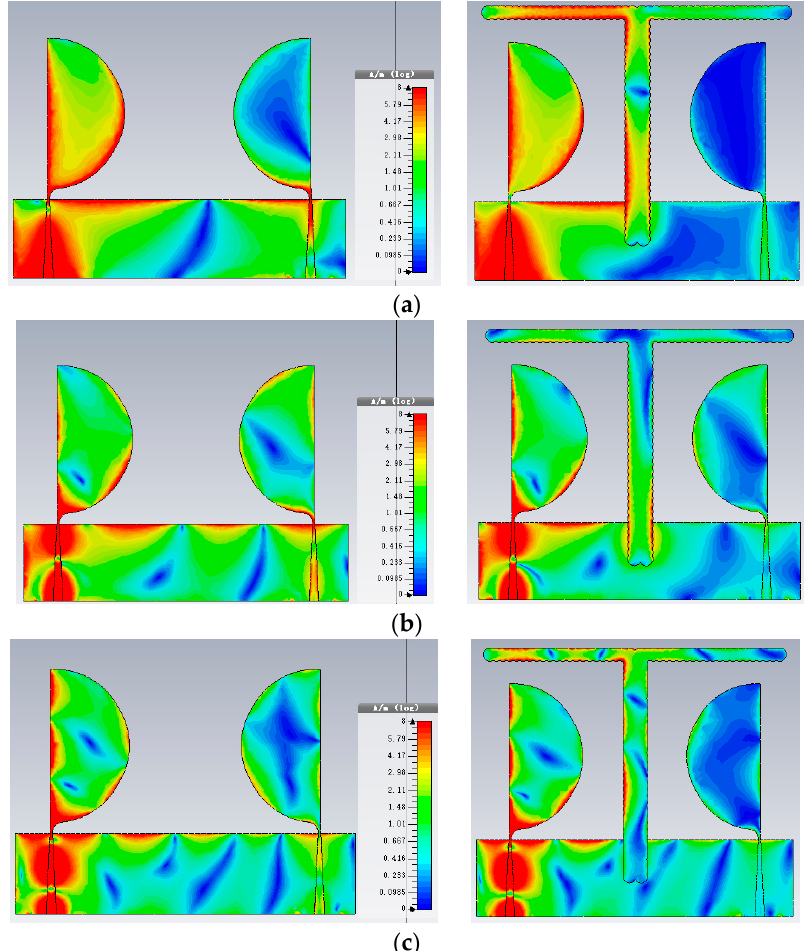
Figure 7. Simulated and measured S-parameters ( a ) S11 ( b ) S21 with t-shape corrugated parasitic element.